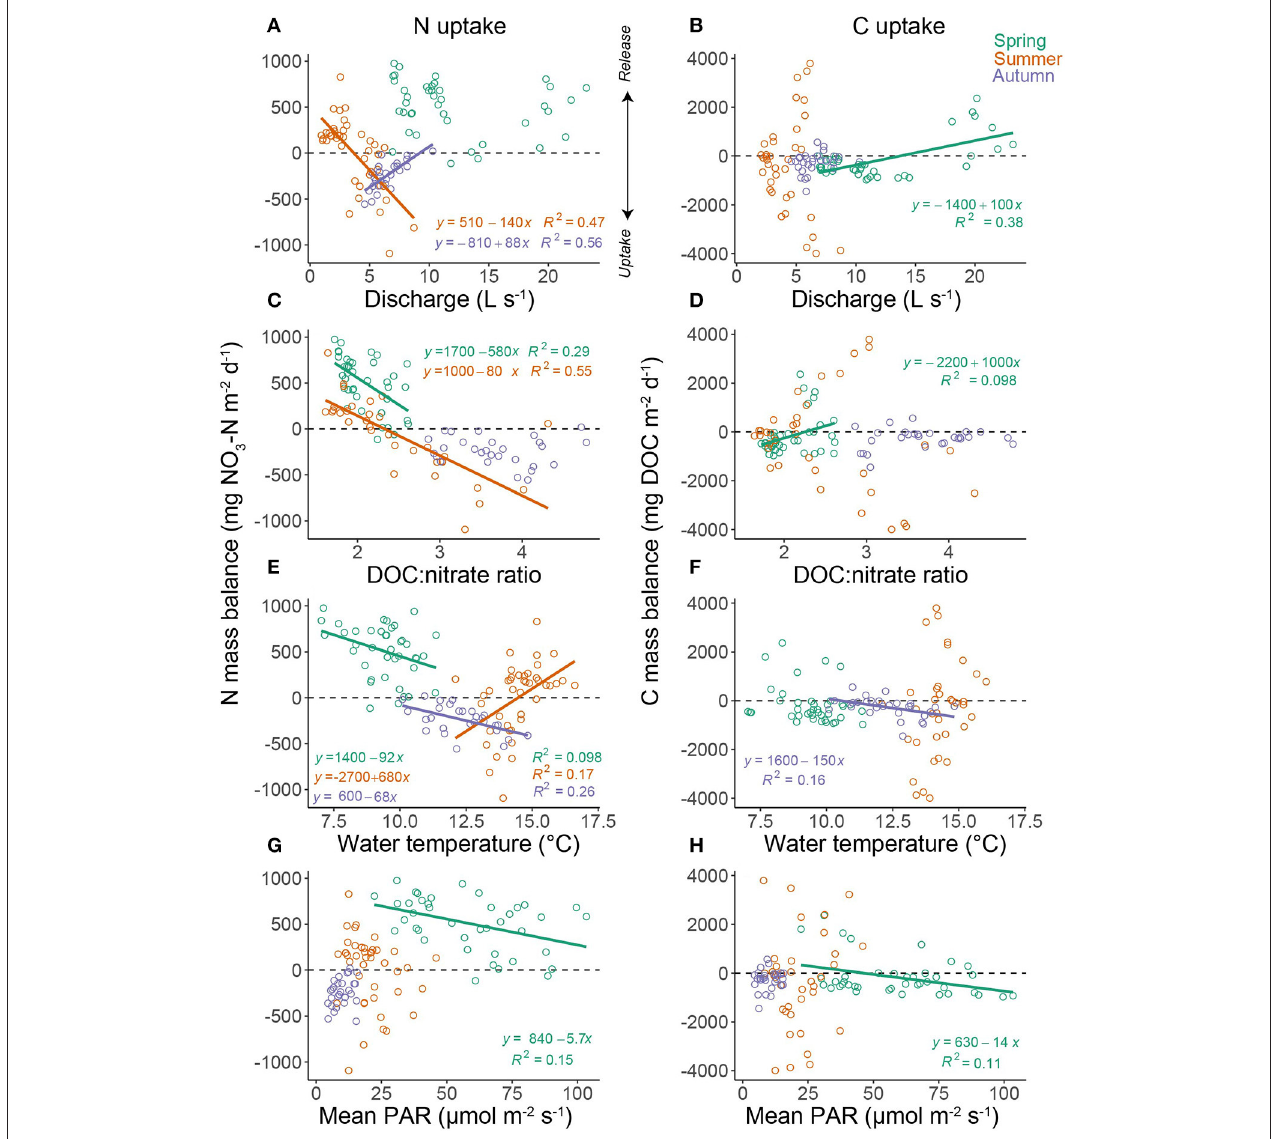
FIGURE 9 | The relationship between daily NO − 3 -N mass balance and mean daily (A) discharge, (C) DOC : nitrate molar ratio, (E) water temperature, and (G) photosynthetic active radiation. The right column displays relationships between daily DOC mass balance and mean daily (B) discharge, (D) DOC : nitrate molar ratio, (F) water temperature, and (H) photosynthetic active radiation. Colour denotes season (i.e., spring, summer, and autumn) with lines representing significant ( P < 0.05) fitted values based on ordinary least squares